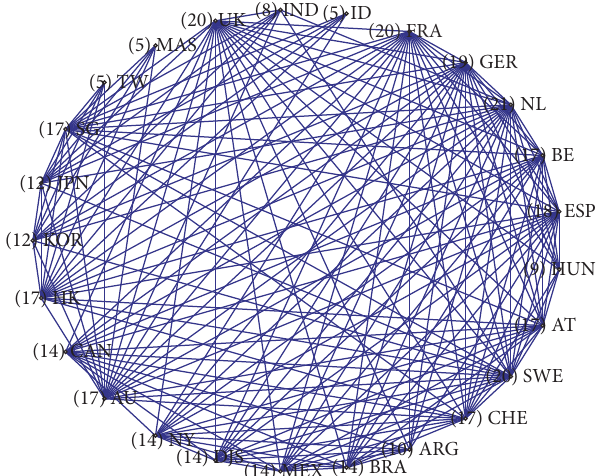
Figure 6: Topology graph of ISMN at 𝜃 = 0.35 .